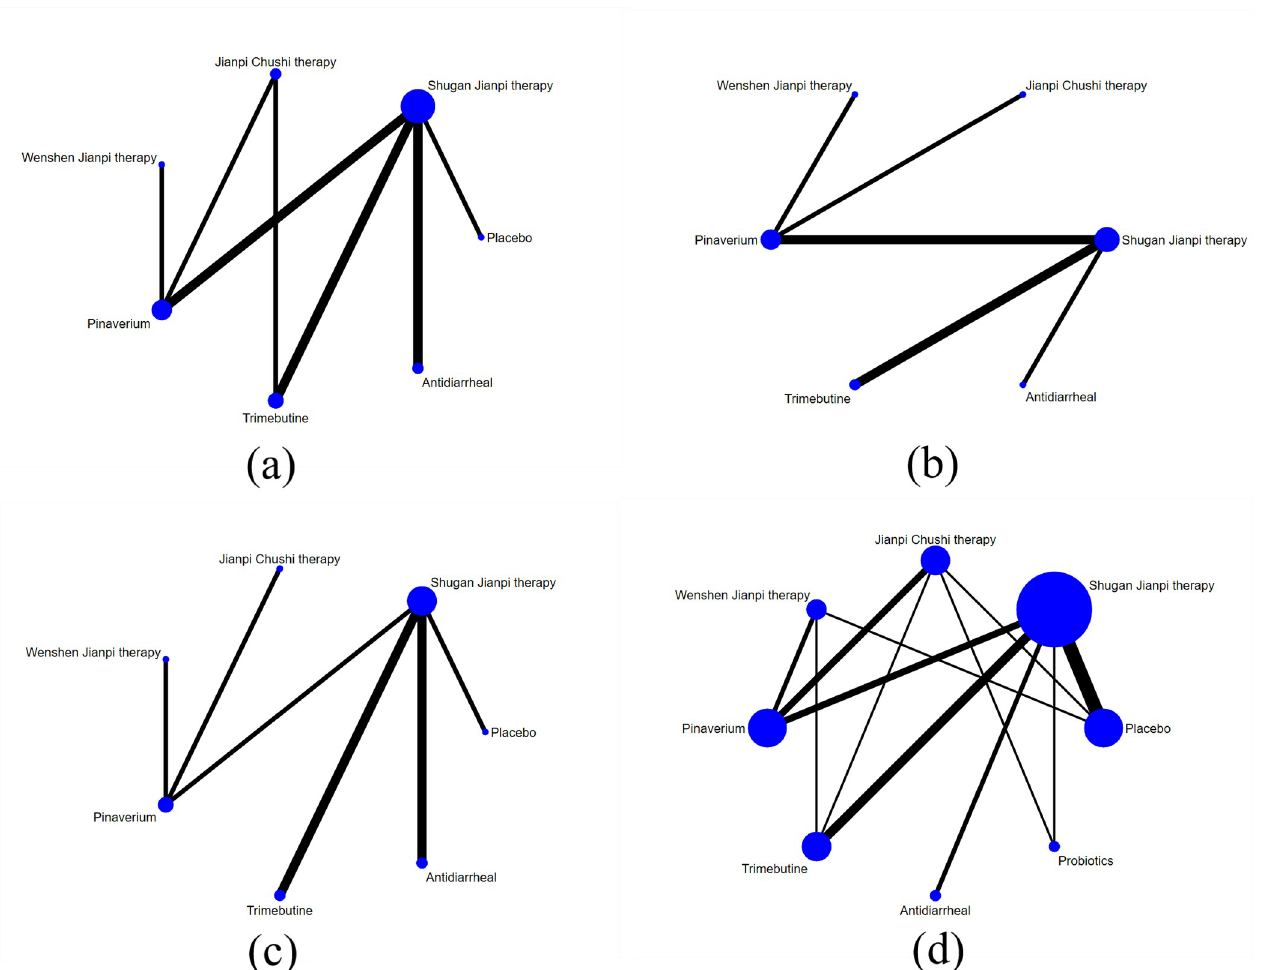
Fig 8. Network evidence of improvement of clinical symptoms and adverse effects: (a) Abdominal pain; (b) Abdominal distension; (c) Stool character; (d) Adverse effects.